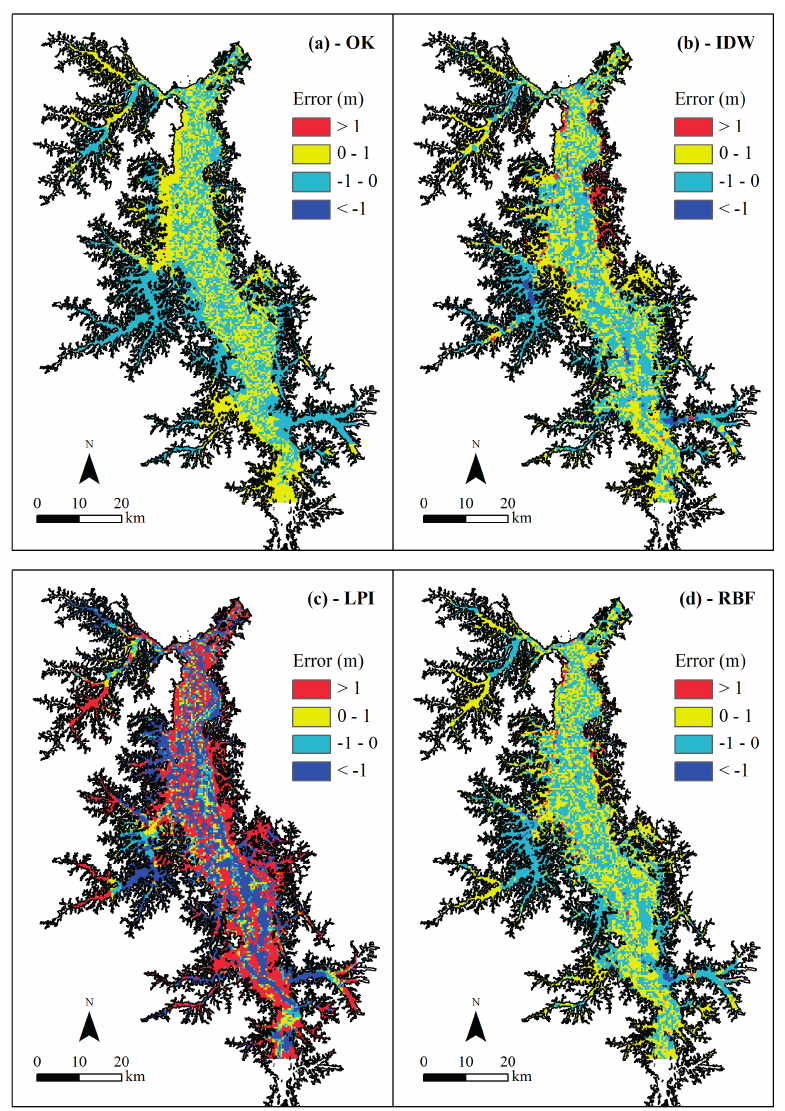
Figure 5. Spatial distribution of error (m) classes for the different interpolation methods: ( a ) Ordinary Kriging—OK; ( b ) Inverse Distance Weighting—IDW; ( c ) Local Polynomial Interpolation—LPI; ( d ) Radial Basis